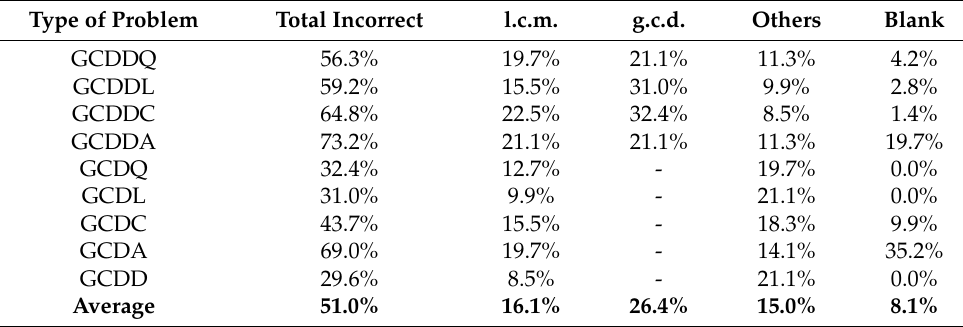
Table 3. Classification of incorrect student resolutions by type of problem.